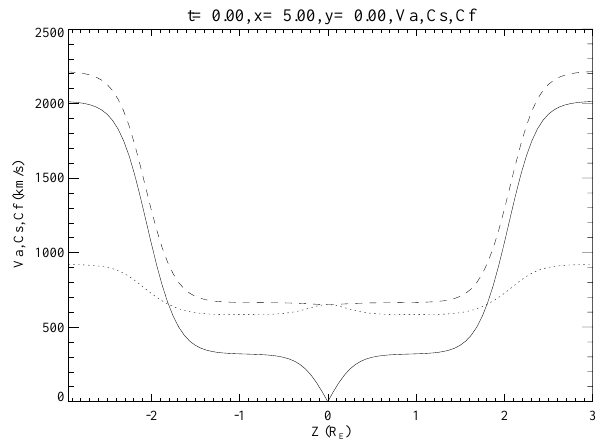
Fig. 1. Profiles of the Alfv´en speed (solid), sound speed (dotted), and fast mode speed (dashed) for the profiles used in the Harris sheet